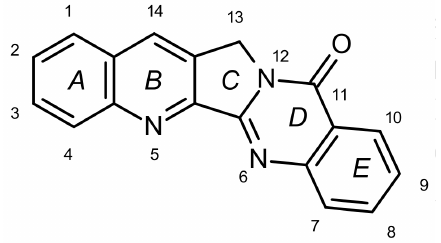
Figure 1. Structure of Luotonin A (IUPAC-conformant numbering